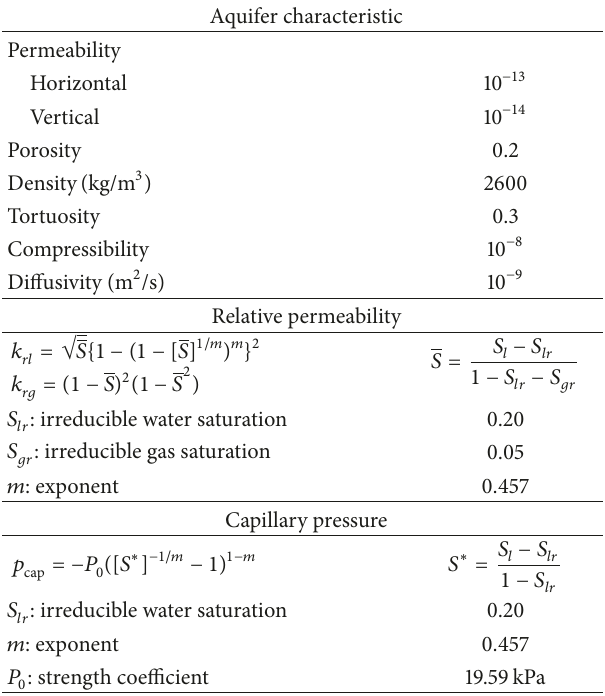
Table 1: Input parameters for shallow groundwater aquifer mate- rials. Relative permeability and capillary pressure follow equations developed by van Genuchten [40].